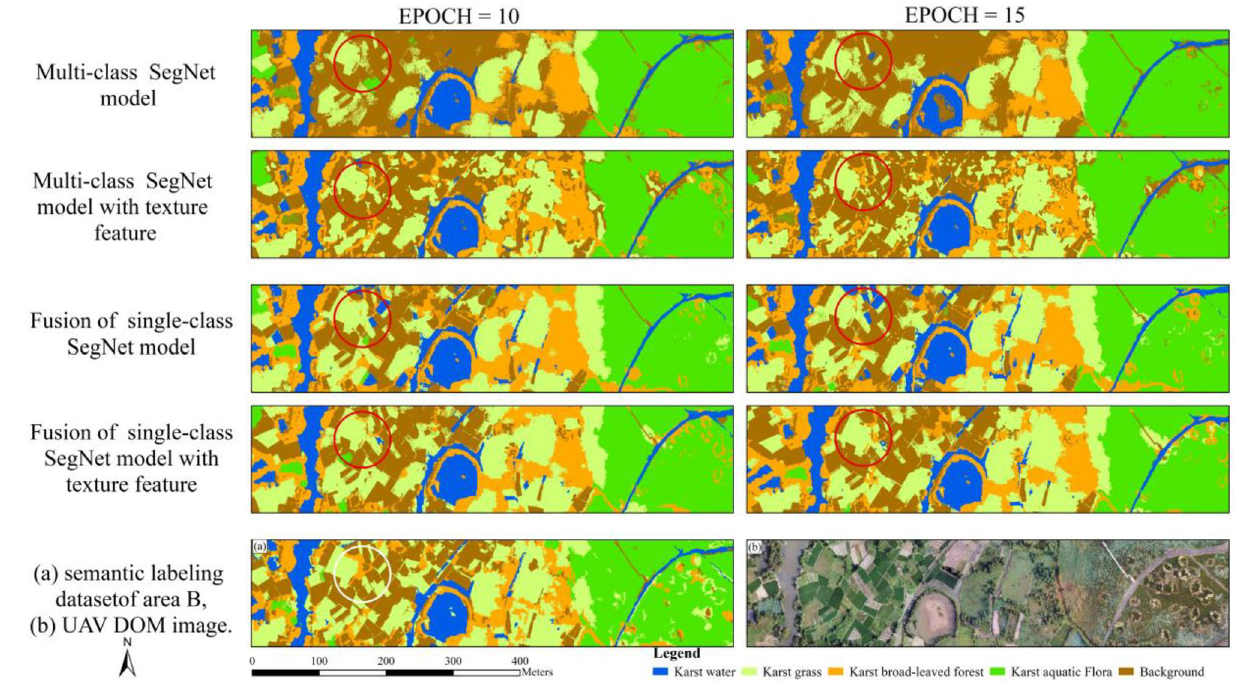
Figure 9. Classifications of multi-classification SegNet models with texture feature. ArcGIS 10.6 software (http:// www. esri. com/ softw are/ arcgis) was used to process and map the data by first author (T. D.). The DOM images and semantic labeling dataset was collected and created by T. D. and B. F.